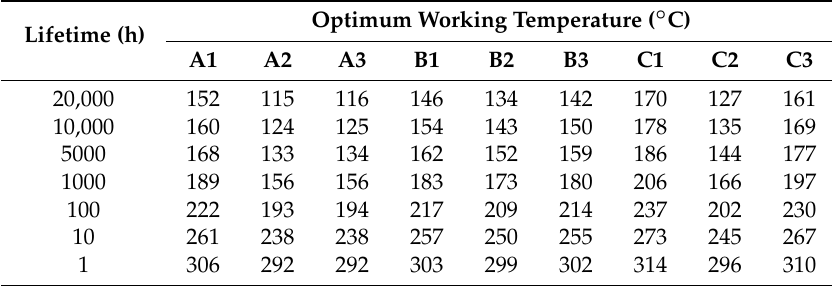
Table 4. Optimum working temperature for all the